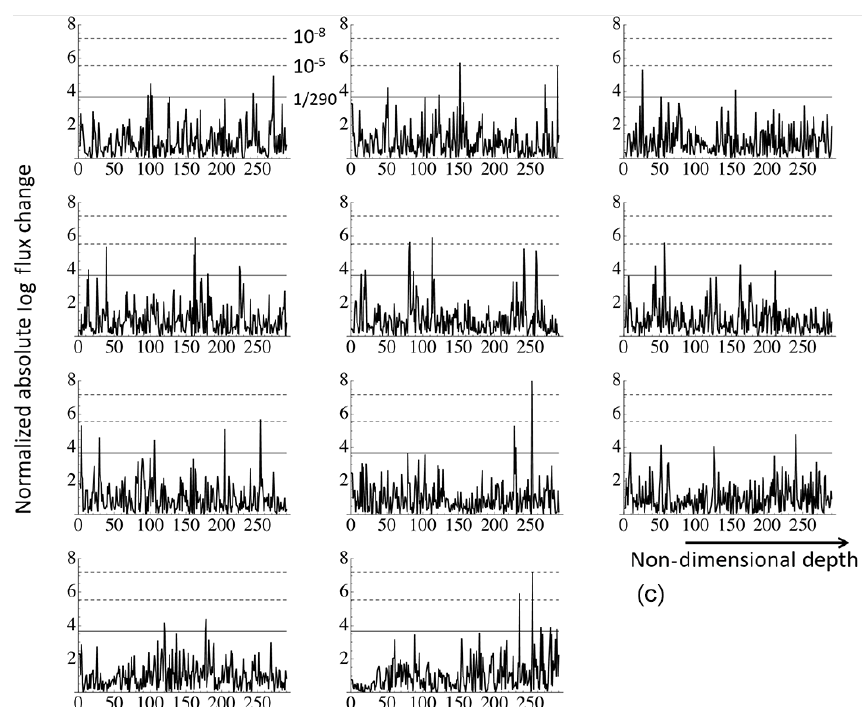
Figure 3. (a) Zooming out of the Holocene dust fluxes by octaves, by doubling the depth resolution from 1cm (upper left) to 11m (lower right) resolution. Starting at the left and moving to the right and from top to bottom (see the ellipses on the first three in the sequence), we zoom out by factors of 2 in depth maintaining exactly 290 data points (effectively non-dimensionalizing the depth; the small number of missing data points were not interpolated so that the final resolution is not exactly 2 10 cm = 10.24m). The temporal resolution is not exactly doubled due to the squashing of the ice column; the total duration (in years) of each section is indicated in each plot; the average temporal resolution of plots is 0.24, 0.48, 0.98, 2.02, 4.32, 10.1 24.5, 54.1, 184, 434, and 2710 years. In order to fit all the curves on the same vertical scale, the dust fluxes were normalized by their mean over each segment. The means (in milligrams per square metre per year) are 0.44, 0.38, 0.30, 0.36, 0.35, 0.33, 0.34, 0.39, 2.48, 2.18, and 2.41, i.e. the first eight plots have nearly the same vertical scales, whereas the last three are about 6 times larger in range. This means that all the plots except the last three are at nearly constant normalization. (b) Same as (a) but for the absolute changes between neighbouring values in dust flux normalized by the corresponding mean over the segment (290 points). The horizontal lines indicate the Gaussian probability levels for p = 1 / 290 (representing the mean extreme for a 290-point segment; full line) as well as p = 10 − 6 (lower dashed line) and p = 10 − 9 (upper dashed line). (c) Same as (a) but for the absolute changes between neighbouring values in the logarithms of dust flux normalized by the corresponding mean over the segment (290 points). The horizontal lines indicate the Gaussian probability levels for p = 1 / 290 (representing the mean extreme for a 290-point segment; full line) as well as p = 10 − 5 (lower dashed line) and p = 10 − 8 (upper dashed line, not the same as in b